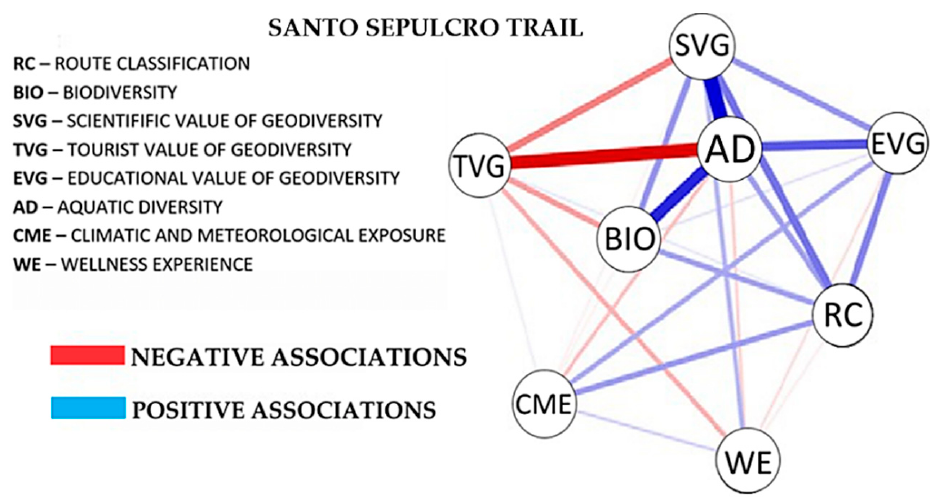
Figure 15. Network Ecosystem’s Health Provision Spectrum of the Santo Sepulcro trail. Network Analysis Ecosystem’s Health Provision Spectrum of the Riacho do Meio Trail In the network configuration in Figure 16 of the Riacho do Meio trail, the main associa- tions were found between the variables Biodiversity (BIO) and Climatic and Meteorological Exposure (CME, 0.29), Route Classification (RC) and Wellness Experience (WE, 0.37), and Scientific Value of Geodiversity (SVG) and Aquatic Diversity (AD, 0.35), all of which were positive. The weight of the other associations of the two geosites can be seen in Table 8.